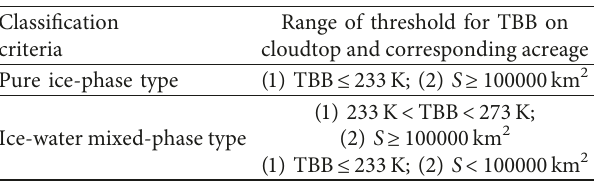
Table 2: The classification of TPV category cloud clusters based on the phase on